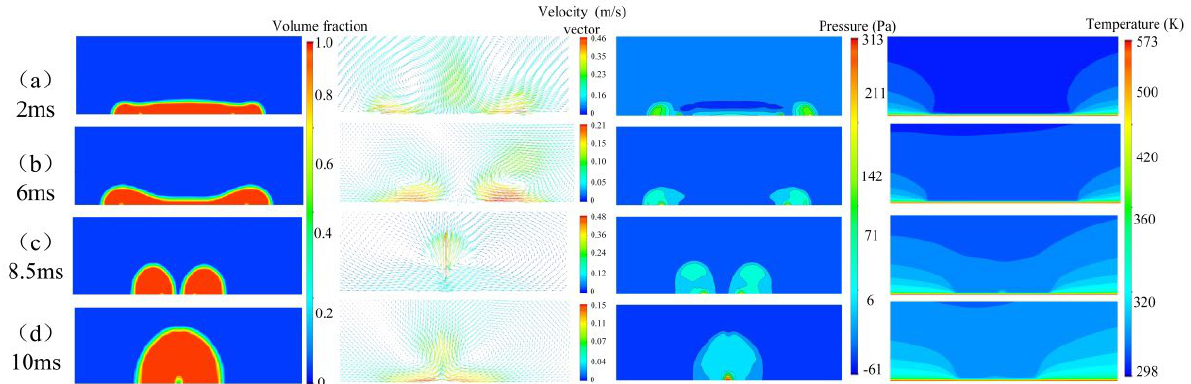
Figure 6. The evolutions of volume fraction, velocity contour, pressure, and temperature of water droplet impacting on a hot surface ( V = 1 m/s, T s = 573 K, D 0 = 1 mm).